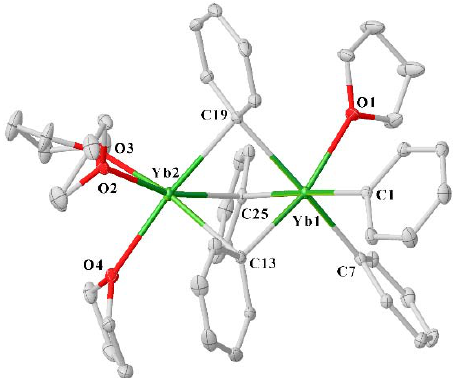
Figure 2. X-ray crystal structure of compound 3 . Thermal ellipsoids are shown at 40%. Hydrogen atoms have been removed for clarity. Table 1. Selected bond lengths of complex 3 and the reported structure of [Yb 2 Ph 5 (thf) 4 ]. This